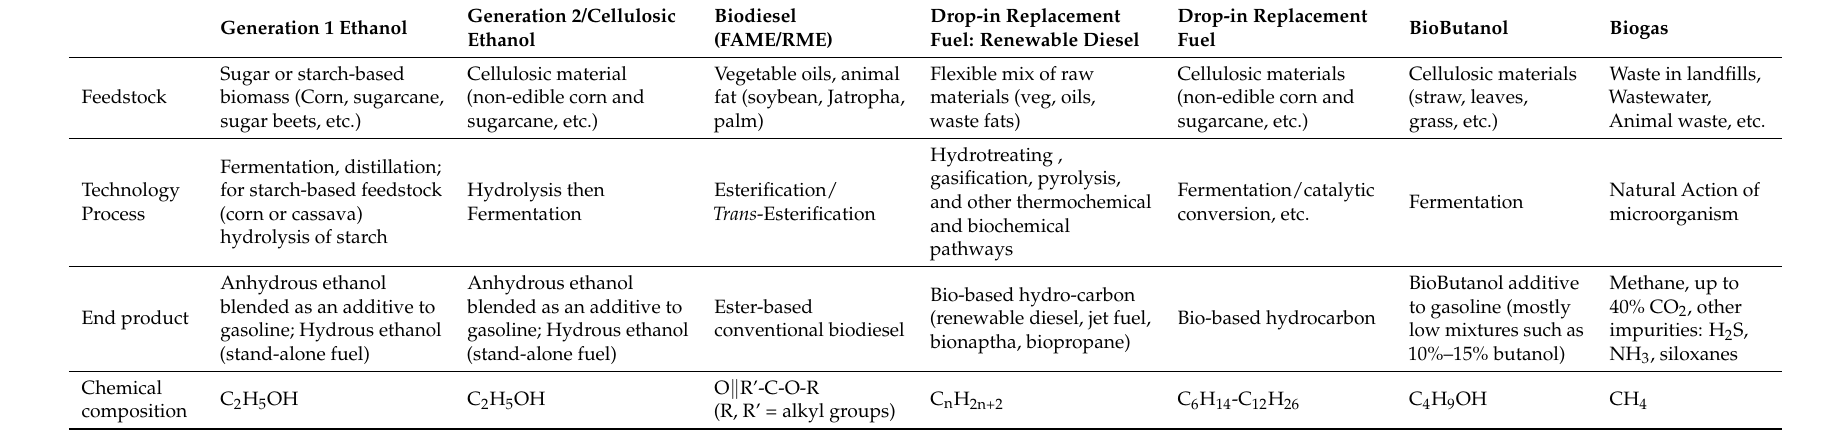
Table 1. Renewable fuel technology